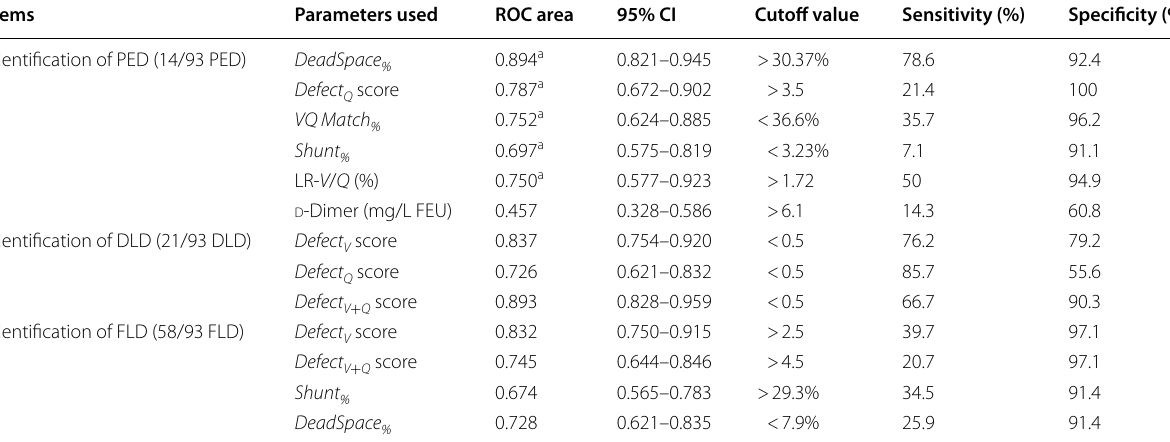
PED: pulmonary embolism-related disease; DLD: diffuse lung involvement disease; FLD: focal lung involvement disease; ARF: acute respiratory failure; ROC: receiver operating characteristic; CI: confidence interval; LR- V / Q (%): relative regional ventilation/corresponding regional perfusion of the lower right region of interest a P < 0.05 vs. d